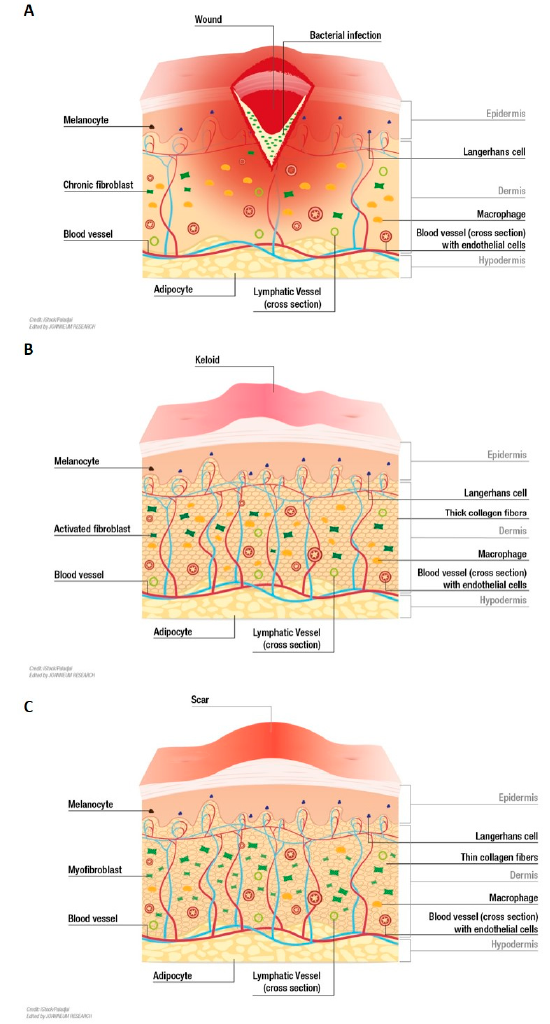
Figure 2. Ideal in vitro models of wound healing disorders envisioned to reproduce clinical key aspects. ( A ) Chronic wounds are characterized by an impaired repair process. A prolonged inflamma- tory phase, hypoperfusion/ischemia, infections, and/or biofilm formation keep chronic wounds from transcending to the proliferation phase [55,56]. ( B ) Keloids are enlarged, raised, tumor-like scars that can even extend beyond the original margins of a wound. Keloid tissue is composed of disorganized, thick, eosinophilic collagen type I and III bundles that are randomly oriented [1]. ( C ) Hypertrophic scars have a red/pink color as well as an elevated and uneven surface. In contrast to keloids, they do not extend beyond the margins of the primary wound. Hypertrophic scars are characterized by the persistence of myo fi broblasts, which contribute to enhanced contraction, and in- creased production of collagen and a-SMA [1,78,79].